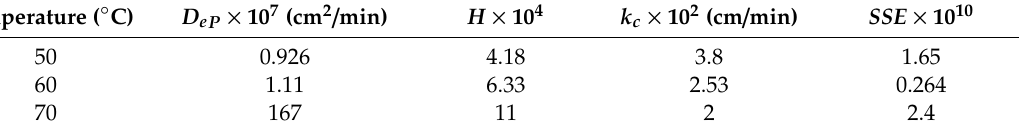
Table 2. The parameter values of the model based on experimental data from the extraction process. Temperature ( ◦ C)